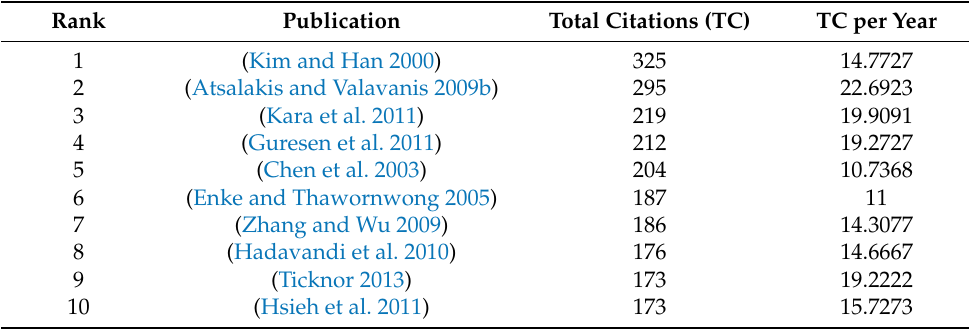
Table 4. Top 10 cited